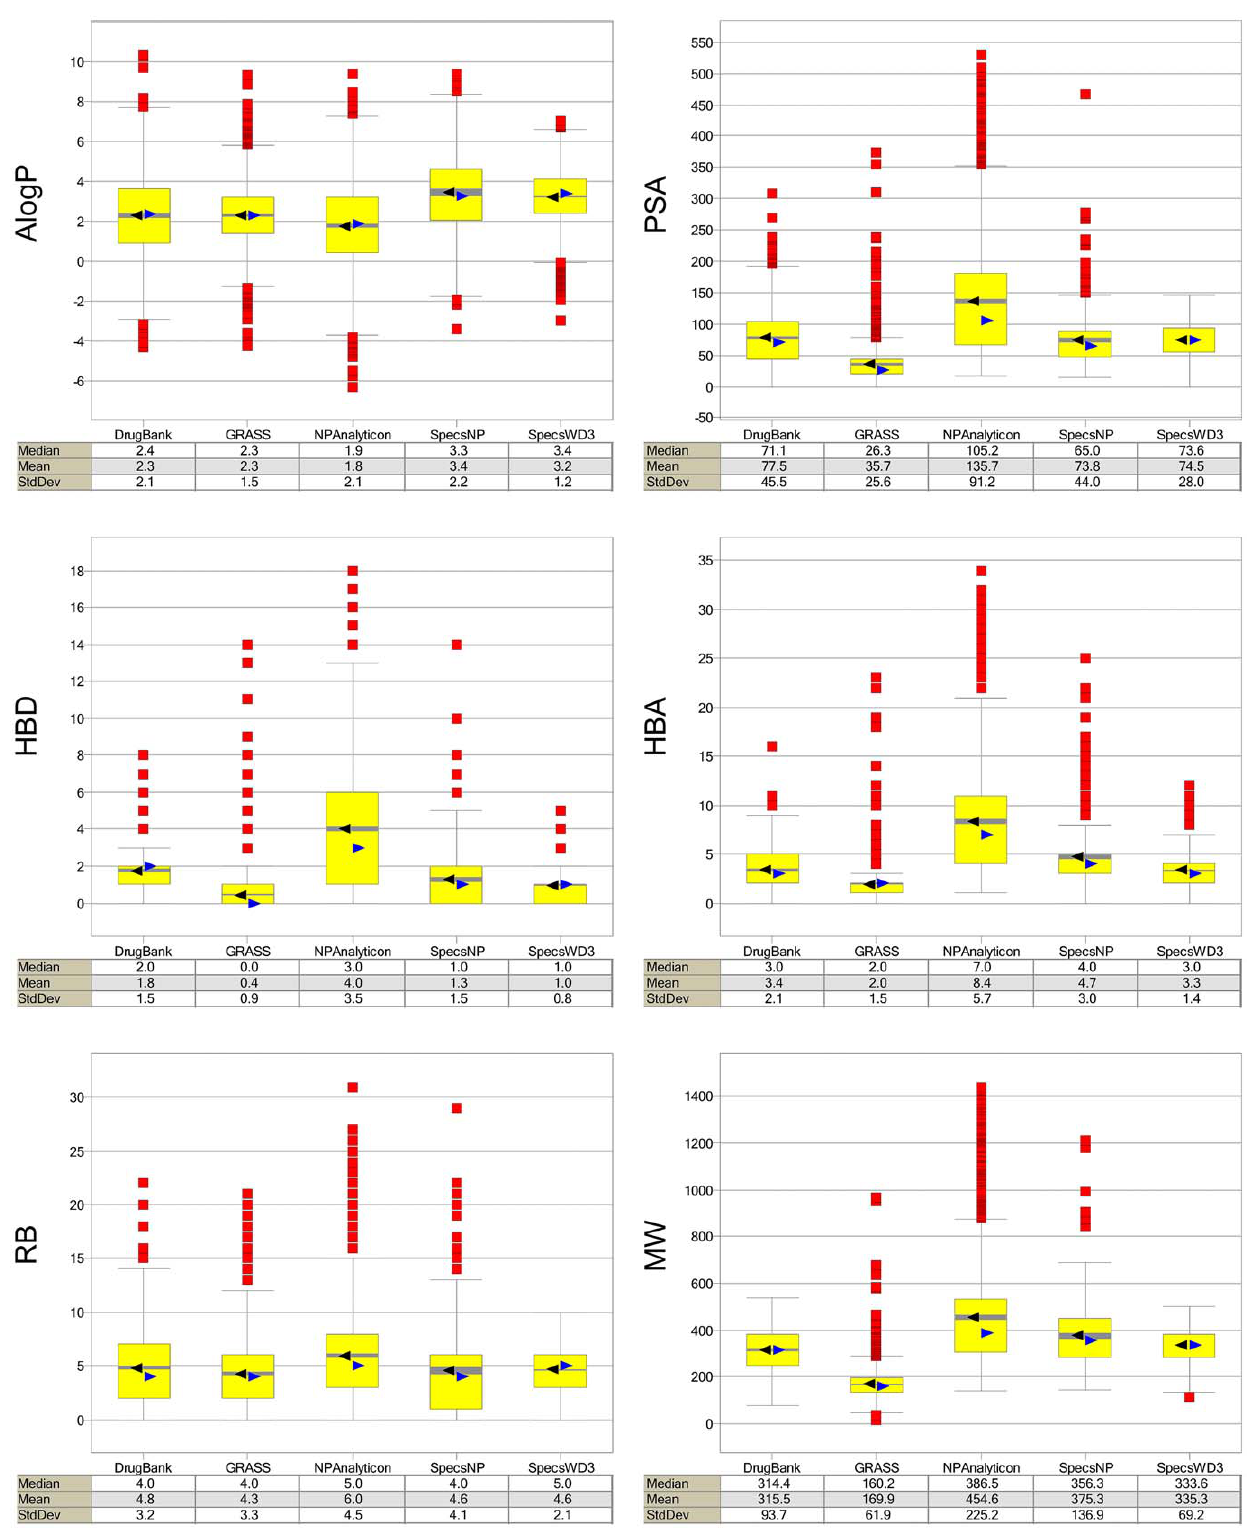
Figure 1. Distribution of six drug-like properties of the databases compared in this work. The yellow boxes enclose data points with values within the first and third quartile; the black and blue triangles denote the mean and median distributions, respectively; the lines above and below indicate the upper and lower adjacent values. The gray band within boxes represents the 95% confidence interval of the mean value (based on the number of data points and StdDev). The red squares indicate outliers. Selected statistics of each distribution are also shown.